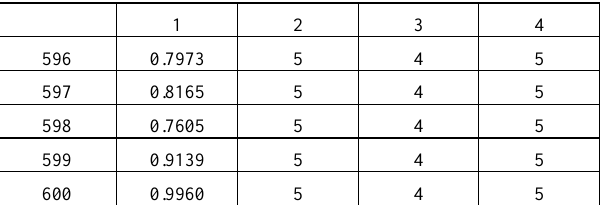
Table 2. Results of the mean absolute error of the neural network 5–4–5